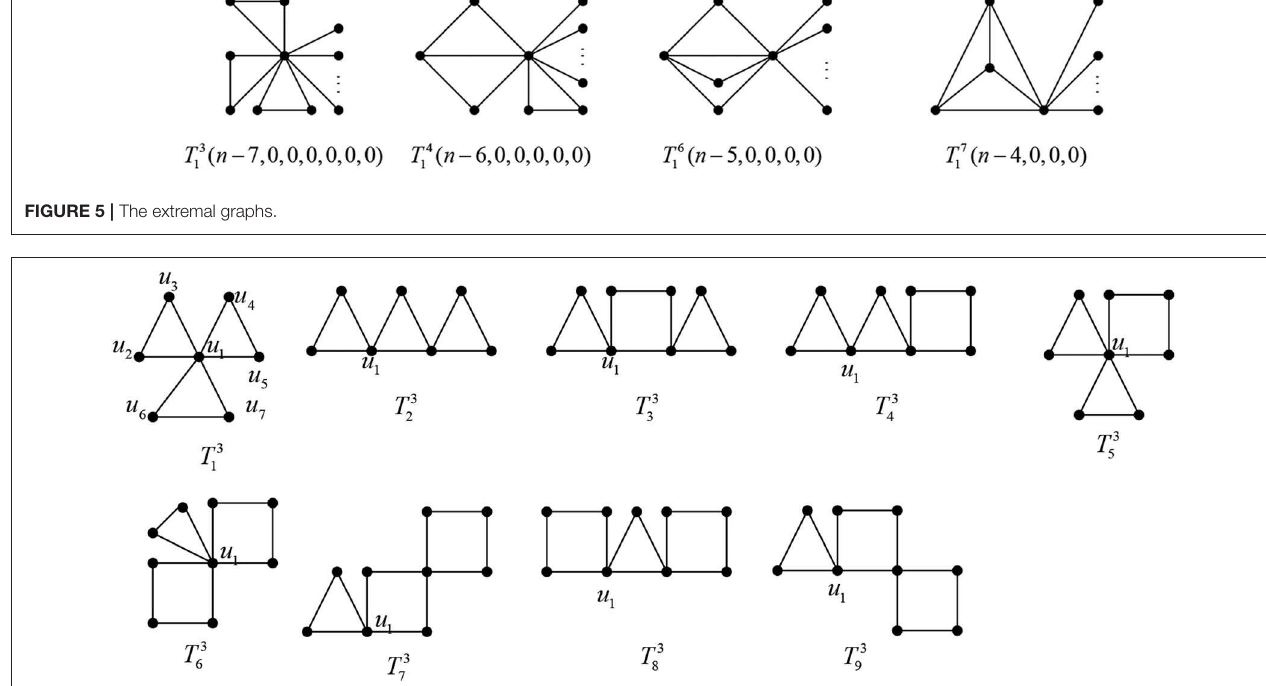
FIGURE 6 | The graphs T 3 i ( i